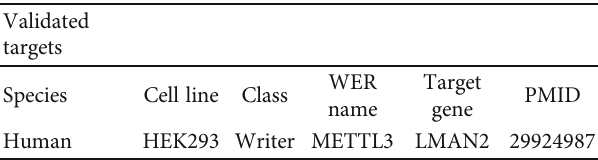
Figure 5: LMAN2 is associated with homologous recombination (HR). (a) HR panel of 16 genes expresses di ff erences in HER2 subtypes. (b) The LMAN2 expression is inversely linked to that of BRCA2, MRE11, and BRIP1. (c) The prognostic analysis shows that BRIP1 has a meaningful prognosis in HER2 subtypes. (d) The HR-associated proteins SLX4, RAD51D, BLM, PALB2, CHEK2, BRIP1, BRCA2, MRE11A, BRCA1, NBN, BARD1, RAD51C, ATR, RBBP8, MRE11, XRCC2, and LMAN2 were used to construct an advanced prognostic model. The lambda parameter displays the coe ffi cients of several characteristics that have been chosen. The LASSO Cox regression model was utilized to plot the partial likelihood deviance vs. log ( λ ). The prognostic analysis of gene signature in TCGA set. The dashed line indicates the median risk score and classi fi es the patients into 2 groups: those at low risk and those at high risk ( ∗∗∗ p ≤ 0 : 001 ; ∗∗ p ≤ 0 : 01 ; ∗ p ≤ 0 : 05 ). Table 3: The experiment validated m6A target